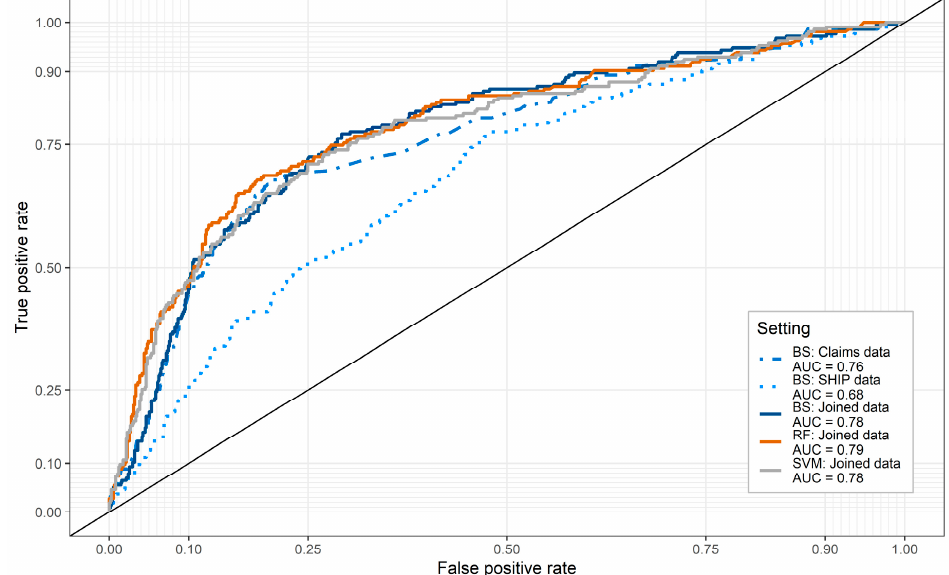
Figure 2. Area under curve (AUC) and receiver-operating-characteristics (ROC) for different best subset models, randomforest, and support vector machines in predicting future LBP-related consultations of physicians. (BS = best subset, RF = randomforest, SVM = support vector machines).